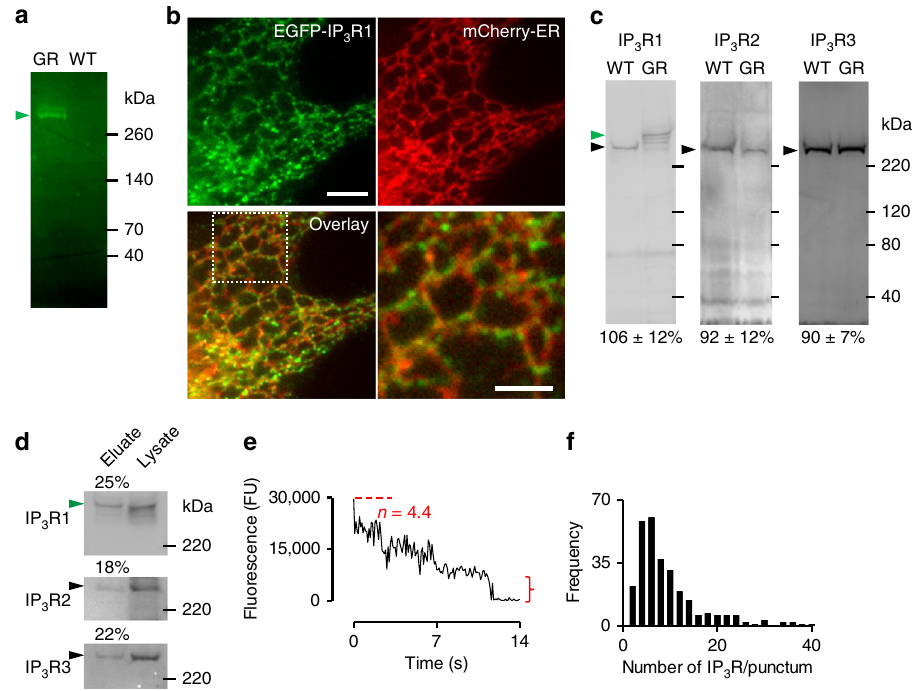
Fig. 1 Endogenous IP 3 R1s form puncta. a In-gel fl uorescence of lysates from EGFP-IP 3 R1 HeLa cells (GR) and control (WT) cells demonstrates that the only fl uorescence is associated with EGFP-IP M 3 R1 (green arrow). Results typical of four gels. Positions of selected r markers (kDa) are shown ( a , c , d ). b TIRFM images of EGFP-IP 3 R1 HeLa cells showing a marker for the ER lumen (mCherry-ER). The merged image and an enlargement of the boxed area show co-localization of EGFP-IP 3 R1 with mCherry-ER (Pearson ’ s coef fi cient with Costes ’ automatic threshold = 0.93 ± 0.02; Costes P value = 1.00, n = 4 cells). Scale bar = 5 µ m (2 µ m for enlargement). c Western blots (WBs) for IP 3 R1-3 show expression of tagged (green arrow, ~290 kDa) and untagged (black arrow, ~260 kDa) IP 3 R1 in GR and WT cells, respectively. Expression of IP 3 R subtypes in GR cells is shown relative to control (WT) cells (%, mean ± SD, n = 3 for IP n = 4 for IP ’ s t -tests indicated no signi fi cant differences between 3 R2 and IP 3 R3, 3 R1). Comparisons of band intensities using paired Student WT and EGFP-IP 3 R1 cells. d WB (IP 3 R1-3 antibodies) from lysates of EGFP-IP 3 R1 HeLa cells after immunoprecipitation with GFP-Trap. Eluate lanes were loaded with sample equivalent to 1.5 times the amounts loaded in the lysate lanes. Numbers show % of each subtype detected in the pull-down ( n = 2). e Photobleaching of a punctum showing the fi nal bleaching step (bracket) and the initial fl uorescence (dashed line) used to calculate the total number of fl uorophores ( n ). FU, fl uorescence units. f Single-step photobleaching results (284 puncta from fi ve cells, Supplementary Fig. 5) were used to calculate the number of tetrameric IP 3 Rs per punctum (8.4 ±